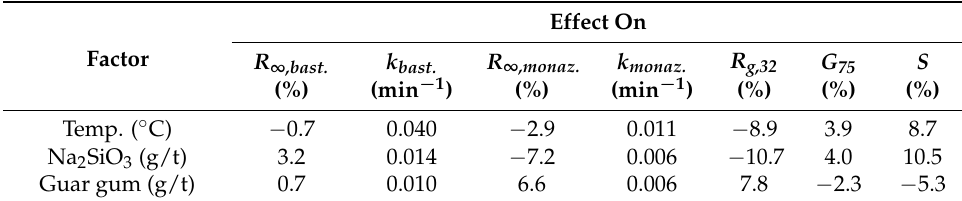
Table 8. Main effects of investigated factors on